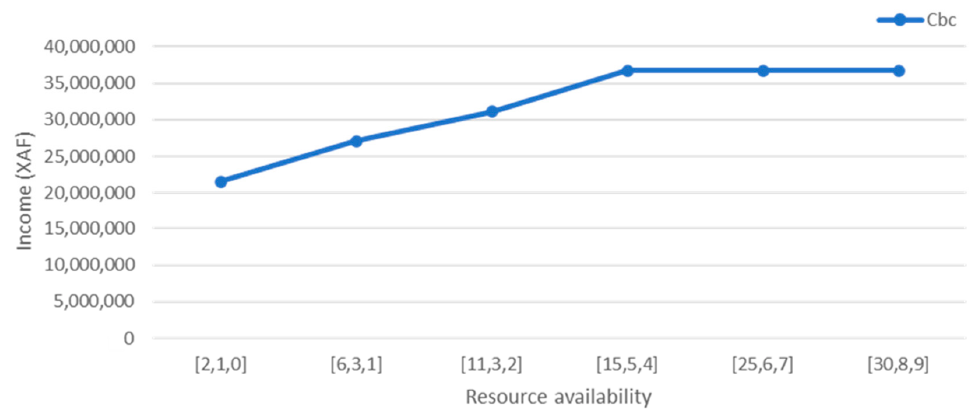
Figure 5. Variation of income according to the availability of resources in scenario 2.